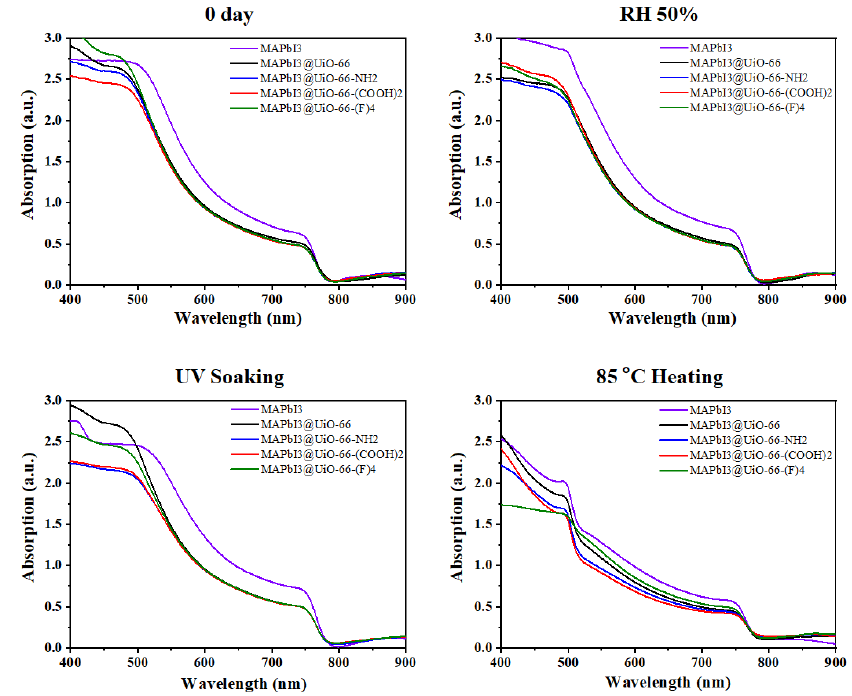
Figure 6. The UV-Vis spectra of the pristine MAPbI 3 and MAPbI 3 @UiO-66 nanocomposite samples before and after humidity, UV-light, and heat aging for two weeks.